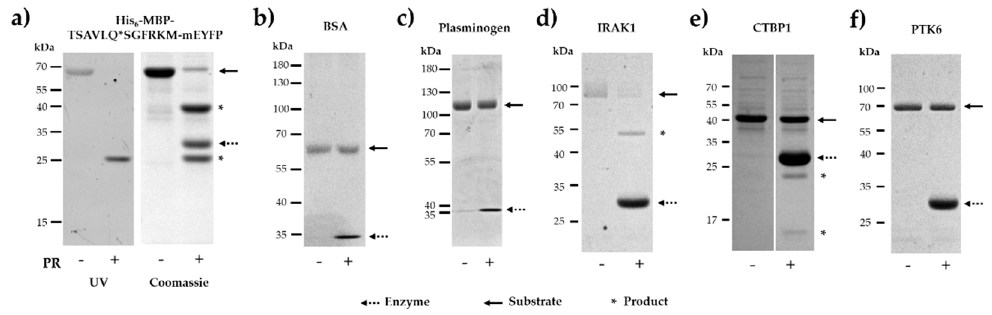
Figure 5. Cleavage of recombinant proteins by SARS-CoV-2 3CLpro. After cleavage reactions by SARS-CoV-2 PR, reaction mixtures were analyzed by SDS-PAGE. Uncleaved proteins and SARS-CoV-2 PR are shown by continuous and dashed lines, respectively, while asterisks indicate cleavage products. ( a ) Cleavage of His 6 -MBP-TSAVLQ*SGFRKM-mEYFP. After in-gel renaturation, the full-length substrate and SGFRKM-mEYFP cleavage product were visualized UV illumination, and the gel was stained with Coomassie dye, as well. ( b ) Cleavage reaction of recombinant BSA. ( c ) Cleavage reaction of recombinant plasminogen. ( d ) Cleavage of reaction recombinant IRAK1. ( e ) Cleavage reaction of recombinant PTK6. ( f ) Cleavage reaction of recombinant CTBP1. Gel images are representatives of ≥ 2 parallel experiments. For negative control, we applied bovine serum albumin (BSA) as a substrate of the untagged enzyme. Neither SSHHPS analysis nor NetCorona webserver predicted SARS-CoV-2 3CLpro